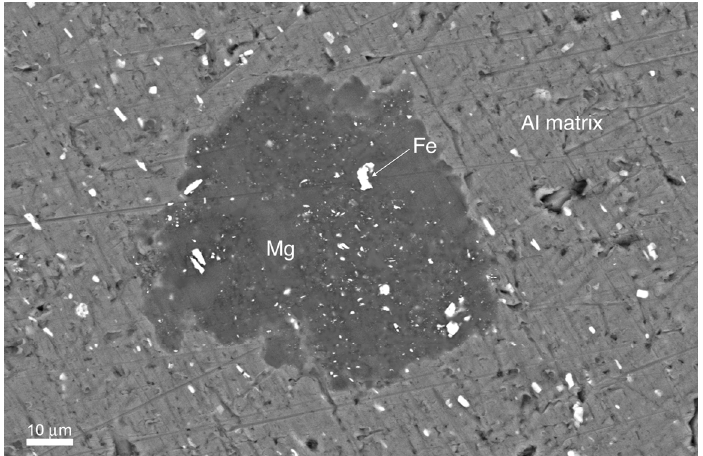
Figure 6. SEM-BSE image of 5 wt% Fe-doped MgH (cross section). The white